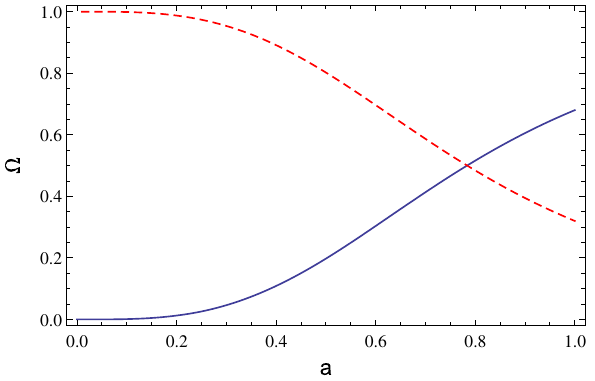
Fig. 4 The evolutional behaviors of the density ratio parameters for the phantom field ( solid line ) and the matter ( dashed line )